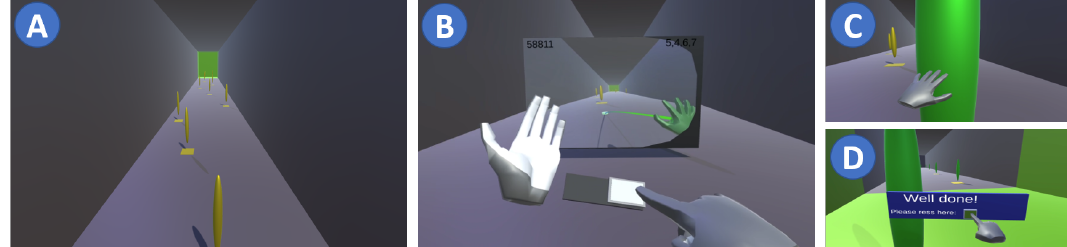
Figure 7. The virtual environment used for the evaluation employs a minimalist rendering style to avoid unwanted changes in subjects’ attention. ( A ) Overview of the environment ( B ) Tutorial video shown to the user. The video can be closed by pushing a button attached to the left hand ( C ) User touching a pillar and change its color. ( D ) User gets notification that the level is completed after touching all